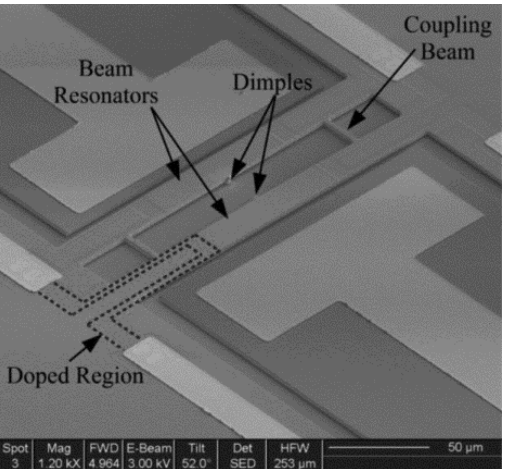
Figure 8. ( a ) SEM image of the coupled cantilevers resonator; ( b ) frequency change in coupled resonator before and after the induced mass. Reproduced with permission from [56]. Rights managed by AIP Publishing.